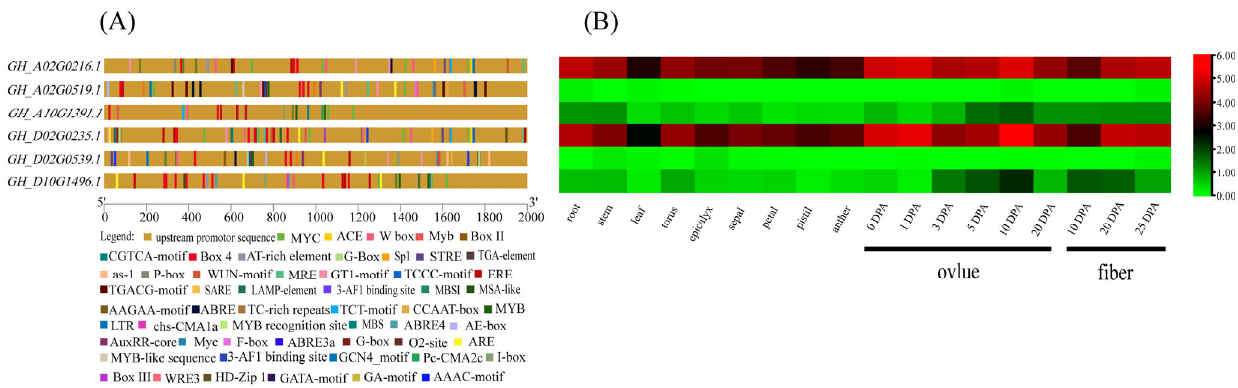
Figure 7. Analysis of Filamin gene family member promoter and its expression pattern in different tissues. ( A ) Cis ‐ elements in promoters of Filamin gene family members. ( B ) Expression pattern of Filamin gene family members in different tissues.